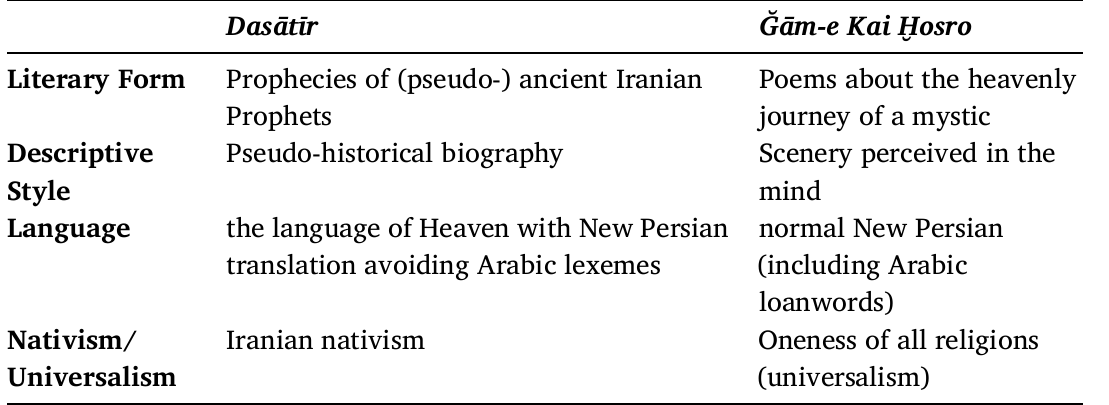
Table 6 Comparison of the Dasātīr and Ğām-e Kai Ḫosro